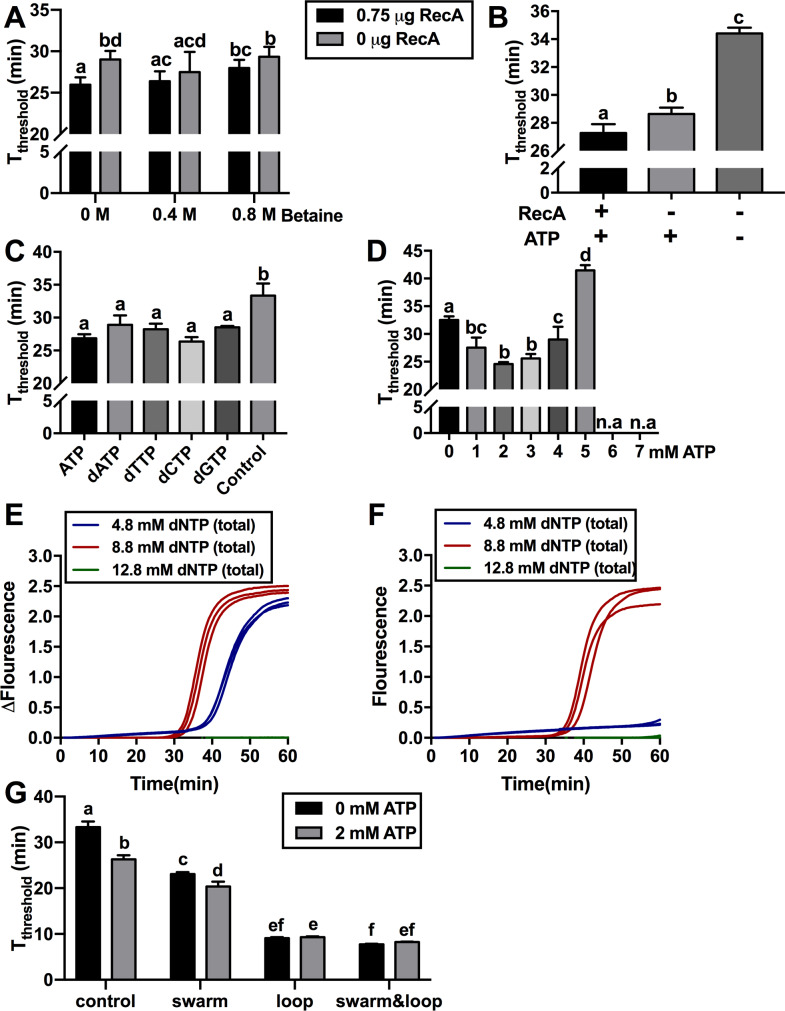
Effect of betaine, recombinase and nucleotide addition on LAMP amplification.(A) Different combinations of RecA and betaine were used in LAMP reactions containing 1 ng target DNA and 1 mM ATP and the time needed for each sample to reach the fluorescence threshold of 0.5 (Tthreshold) in real-time LAMP was determined (n = 10). (B) RecA and/or ATP were added into reactions containing 0.4 M betaine. Reactions without RecA and ATP were used as control (n = 3). “+” and “-” below each bar indicated the present and absent of the component respectively. (C) Additional 1 mM ATP, dATP, dTTP, dCTP or dGTP was added into reactions containing 0.4 M betaine. Reactions without additional ATP and dNTP were used as controls. (D) Different amounts of ATP were added into reactions containing 0.4 M betaine (n = 3). To investigate interplay between dNTPs and Mg2+, 4.8 mM (dark blue), 8.8 mM (red) or 12.8 mM (green) total dNTPs was added into reactions containing 0.4 M betaine and either (E) 8 mM Mg2+ or (F) 10 mM Mg2+ respectively. (G) Two sets of reactions containing 0.4 M betaine and either 0 mM (black) or 2 mM (grey) ATP were prepared. Additional swarm and/or loop primers along with standard LAMP primers were added into each set of reactions. Standard LAMP primers alone were used as controls (n = 4). All Tthreshold data was analysed using one-way ANOVA with a post-hoc Tukey’s multiple comparison of means test (p value < 0.05). Error bars represent standard deviation.